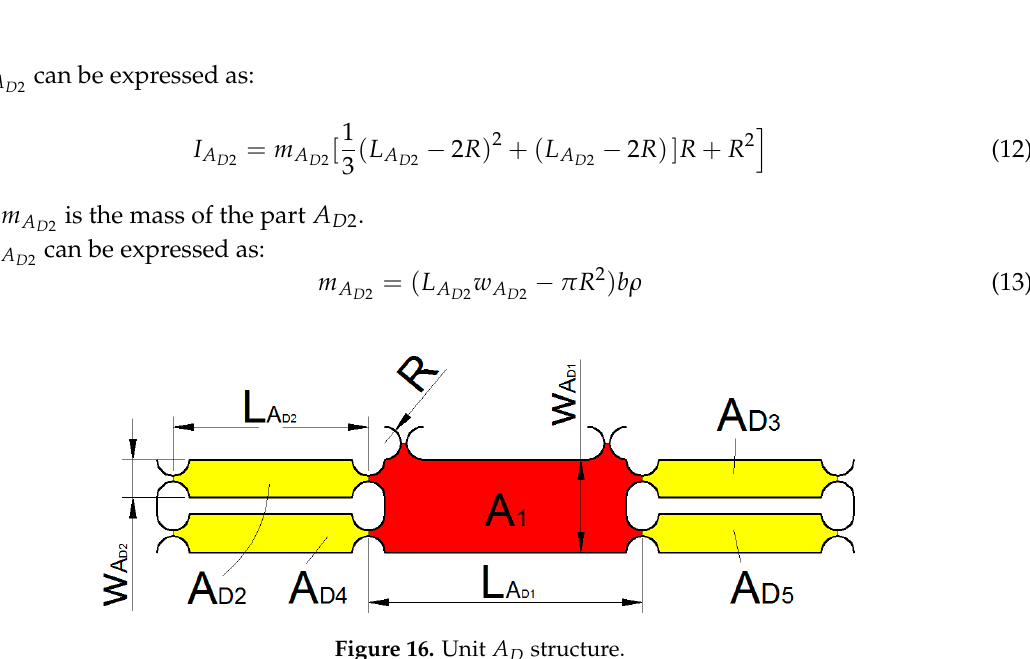
Figure 16. Unit 𝐴 (cid:3005) structure.